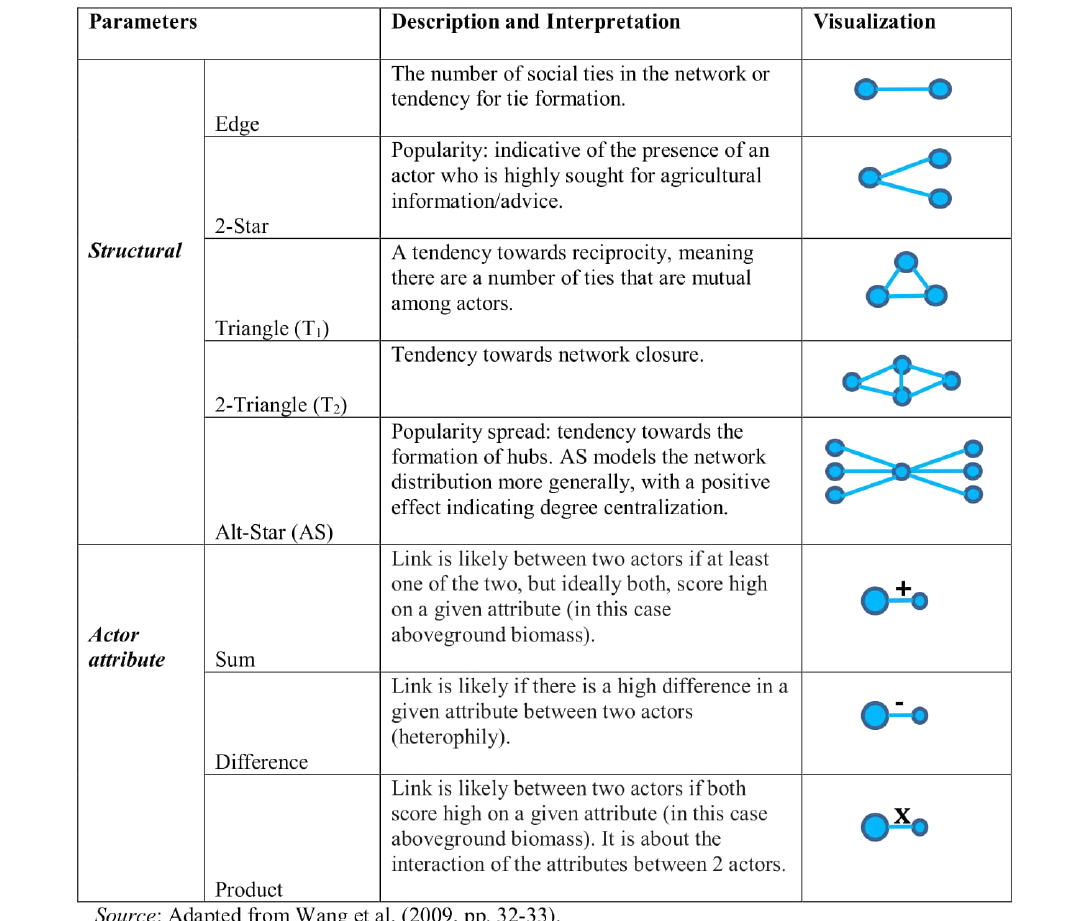
Fig. 2 . Structural and actor attribute parameters included in